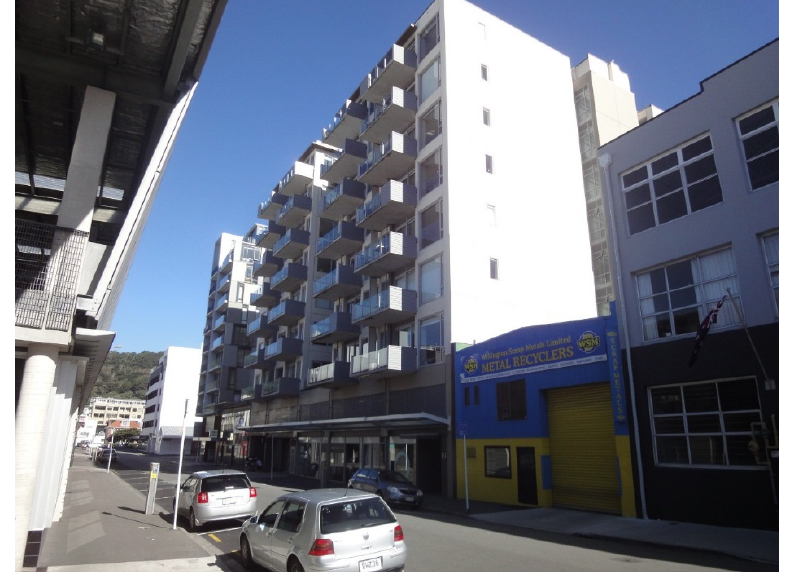
Figure 7. The Trinity Apartments building, in the middle, establishes a poorly regarded relationship with its neighbours. The public also dislike the large blank side wall and the private balconies projecting beyond the site and into the public street